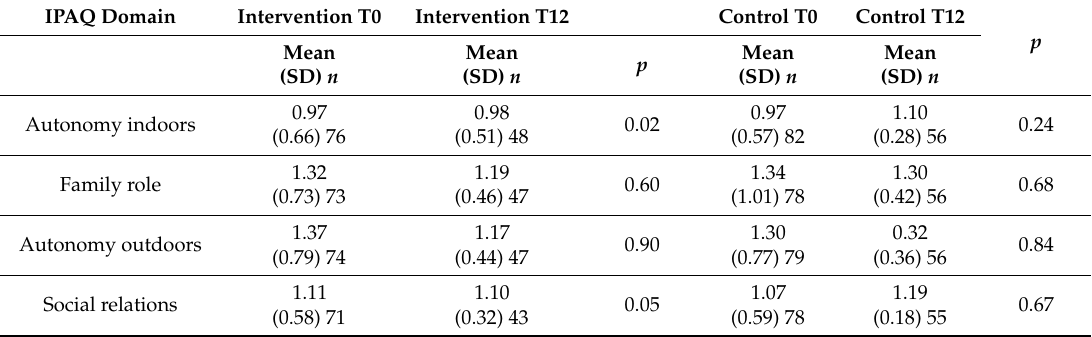
Table 2. Scores of intervention and control group on IPAQ at di ff erent